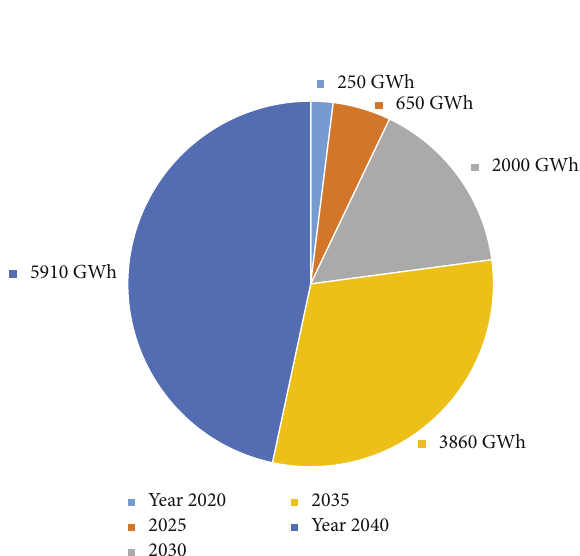
Figure 2: Development of global Li-ion batteries in